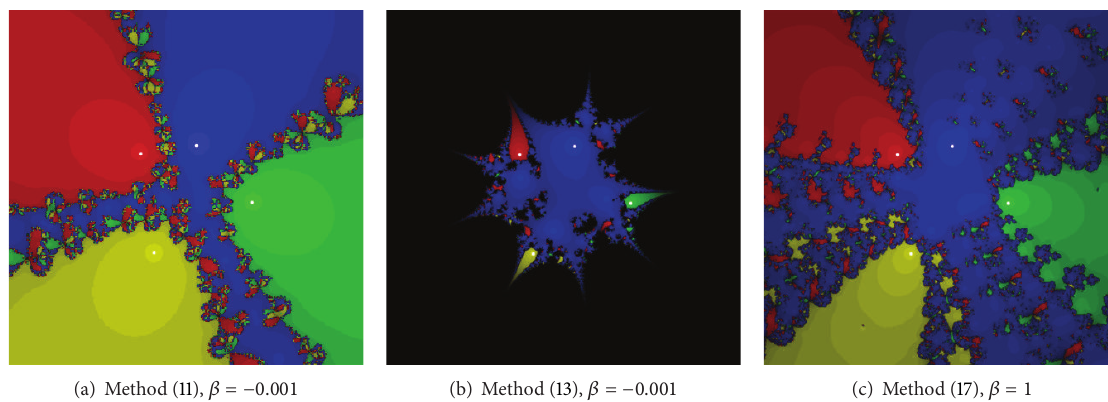
Figure 23: Basins of attraction of (11), (13), and (15) for the test problem 4.